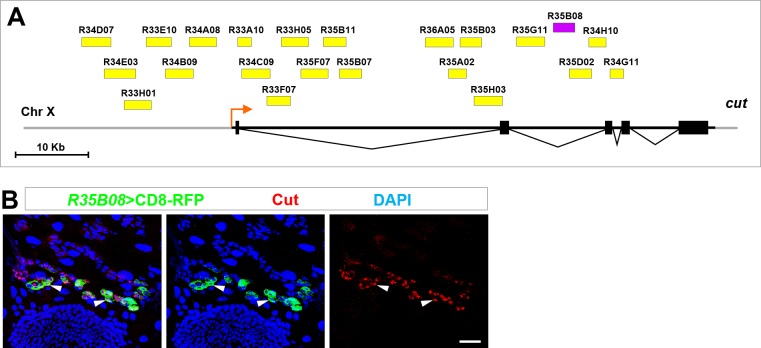
Identification of an intronic enhancer conferring temporospatial induction of cut in future RPs.(A) The gene map of cut locus showing the 22 genomic regions screened for enhancer(s) conferring cut expression in future RPs. Cut-intron2-enhancer (35B08) is represented as a purple bar, whereas the rest of the putative enhancers are represented as yellow bars. (B) R35B08-Gal4 drove specific expression of UAS-CD8-RFP in future RPs, colocalizing with endogenous Cut. Scale bar, 25 μm.